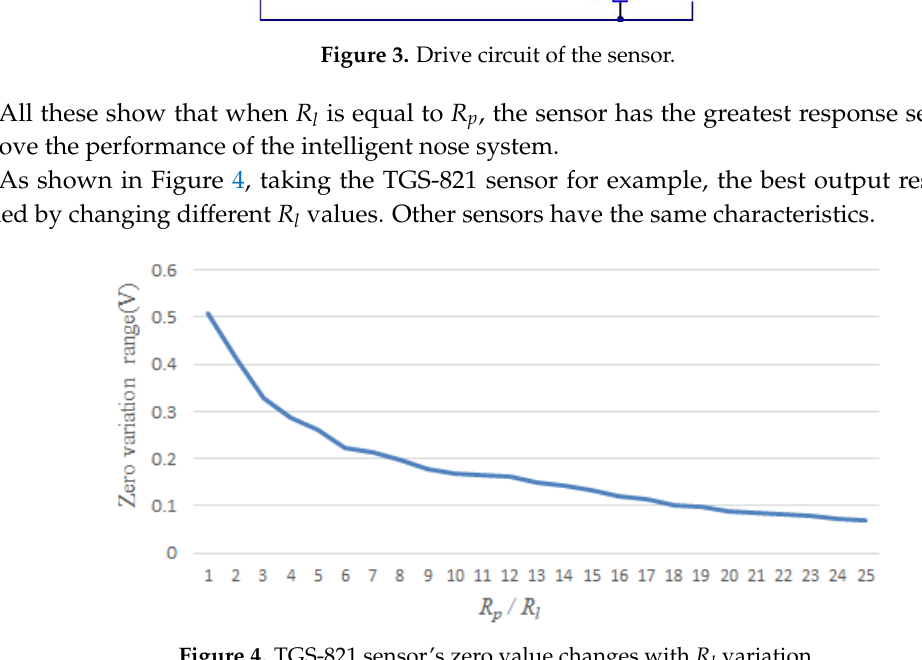
Figure 3. Drive circuit of the sensor.